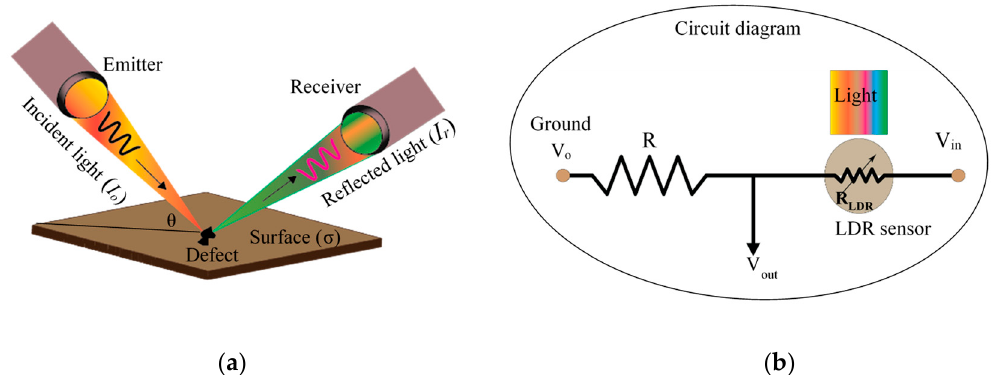
Figure 1 . Complete procedure of the proposed method: ( a ) schematic picture of the optical sensor working principle and ( b ) the built circuit diagram.